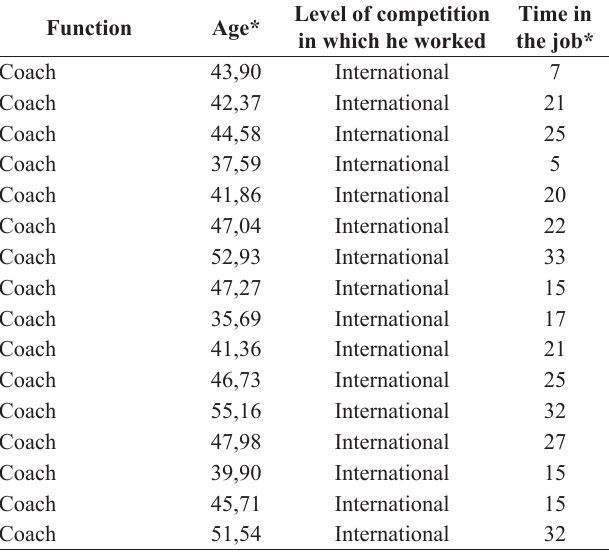
Table 1: Sample characterization